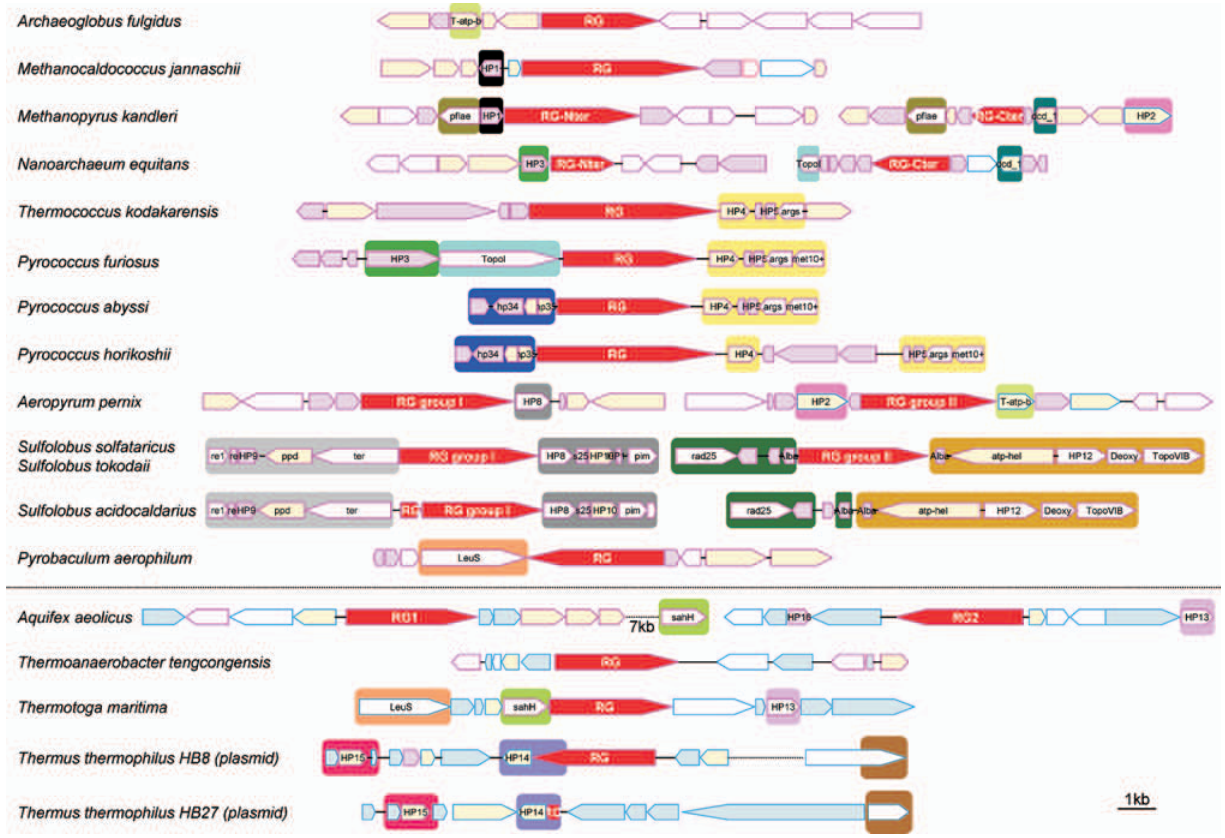
Figure 1. Genomic organization of the regions surrounding reverse gyrase genes. Blue boxes indicate genes having exclusively bacterial or bacte- rial and eukaryotic homologues; pink boxes indicate genes having exclusively archaeal or archaeal and eukaryotic homologues; yellow boxes in- dicate genes having both archaeal and bacterial homologues; and empty boxes indicate genes with homologues in the three domains of life. The color of the box frames indicates the nature of each gene's closest homologue by BLASTP searches (blue = bacterial; and pink = archaeal). Large boxes with the same color surrounding genomic fragments indicate regions sharing homologous genes. The scale bar represents approximately 1000 nucleotides. Gene name abbreviations: T-atp-b = ABC transporter, ATP-binding protein (COG1131); HP1 = hypothetical protein (COG1590); pflae = pyruvate-formate lyase-activating enzyme (COG1180); dcd_1 = deoxycytidine deaminase (COG0717); HP2 = un- characterized membrane protein (COG3174); HP3 = hypothetical protein (COG2433); TopoI = DNA topoisomerase I (COG0550); HP4 = pre- dicted transcriptional regulators (COG1378); HP5 = uncharacterized Zn-finger containing protein (COG1645); args = arginase 1-like protein (COG0010); met10+ = met-10+ protein (COG2520); HP6 = uncharacterized membrane-associated protein/domain (COG2512); HP7 = pre- dicted DNA-binding proteins with PD1-like DNA-binding motif (COG1661); HP8 = predicted amidohydrolase (COG0388); re1 = DNA-directed RNA polymerase, subunit E (COG1095); re = DNA-directed RNA polymerase, subunit E (COG2093); HP9 = hypothetical protein (COG1909); ppd = phosphonopyruvatedecarboxylase(COG3635); ter= transitionalendoplasmicreticulumATPase(COG0464); s25 = SSU ribosomalprotein S25E (COG4901); HP10 = membrane protein implicated in regulation of membrane protease activity (COG1585); HP11 = predicted tran- scriptional regulators containing the CopG/Arc/MetJ DNA-binding domain (COG3609); pim = protein L-isoaspartate methyltransferase (COG2519); rad25 = DNA repair protein rad56 (COG1061); Alba = archaeal DNA-binding protein (COG1581); atp-heli = ATP-dependent helicase (COG1201); HP12 = hypothetical protein (COG1690); Deoxy = deoxyhypusine synthase (COG1899); TopoVIB = DNA topoisomerase VI subunit B (COG1389); LeuS = leucyl-tRNA synthetase (COG0495); sahH = adenosylhomocysteinase (COG0499); HP13 = hypothetical pro- tein (COG1578); HP14 = predicted metal-dependent membrane protease (COG1266); HP15 = hypothetical protein (COG1604); and HP16 = hy- pothetical protein